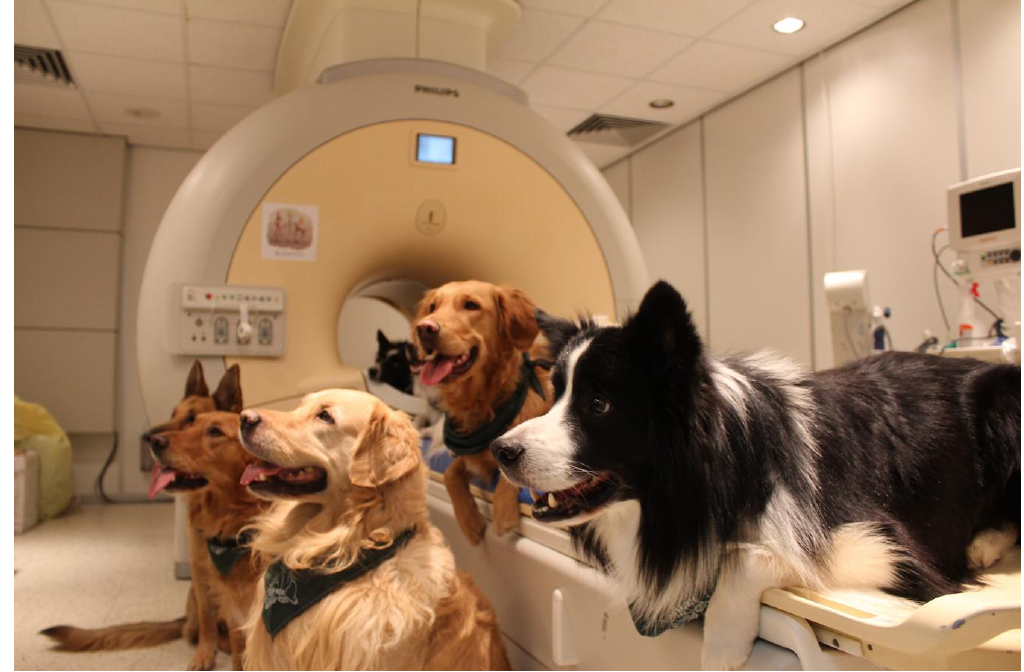
Figure 1. Participants of the Senior Family Project, fMRI trained dogs.